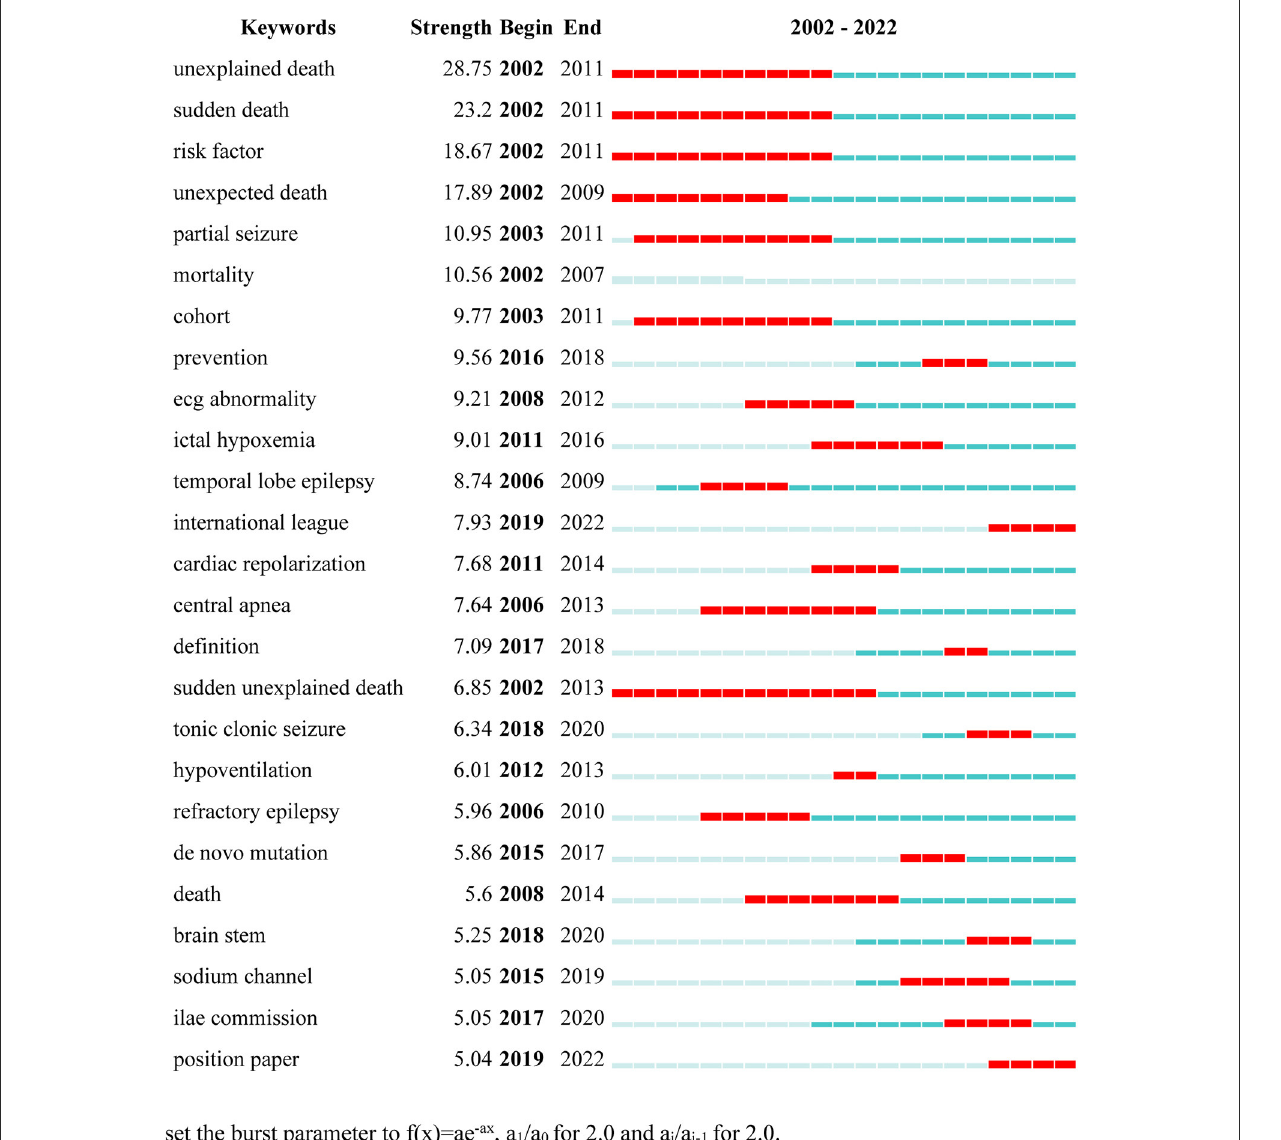
FIGURE6 Top 25 keywords with the strongest citation